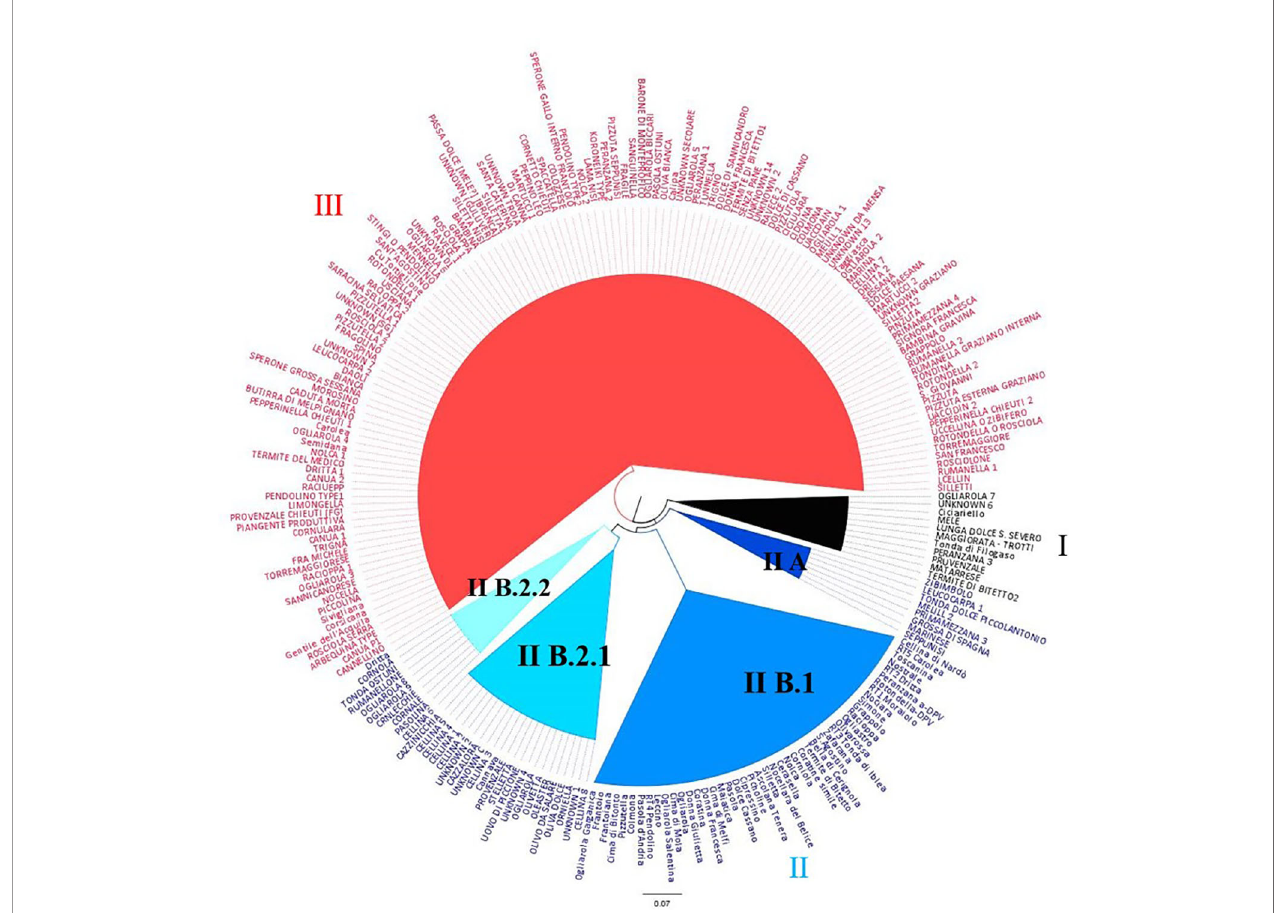
FIGURE 3 | Dendrogram generated by Neighbor-Joining clustering method, illustrating the phylogenetic relationships among 236 olive genotypes, using the SSR